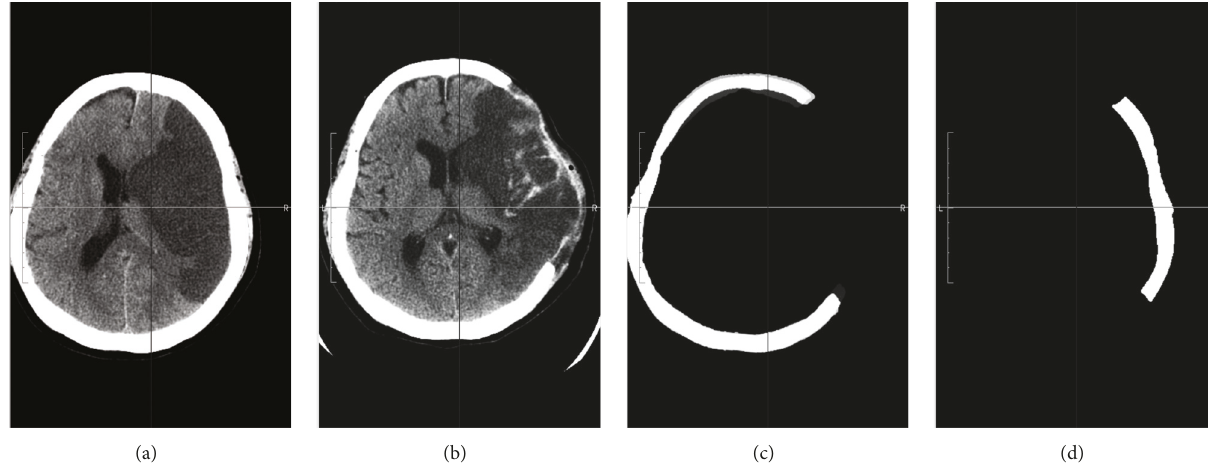
Figure 1: Illustration of image processing to generate the skull flap removed through craniectomy. From (a) to (d): preoperative images, postoperative images, registered postoperative images (bone only), and the missing skull flap by